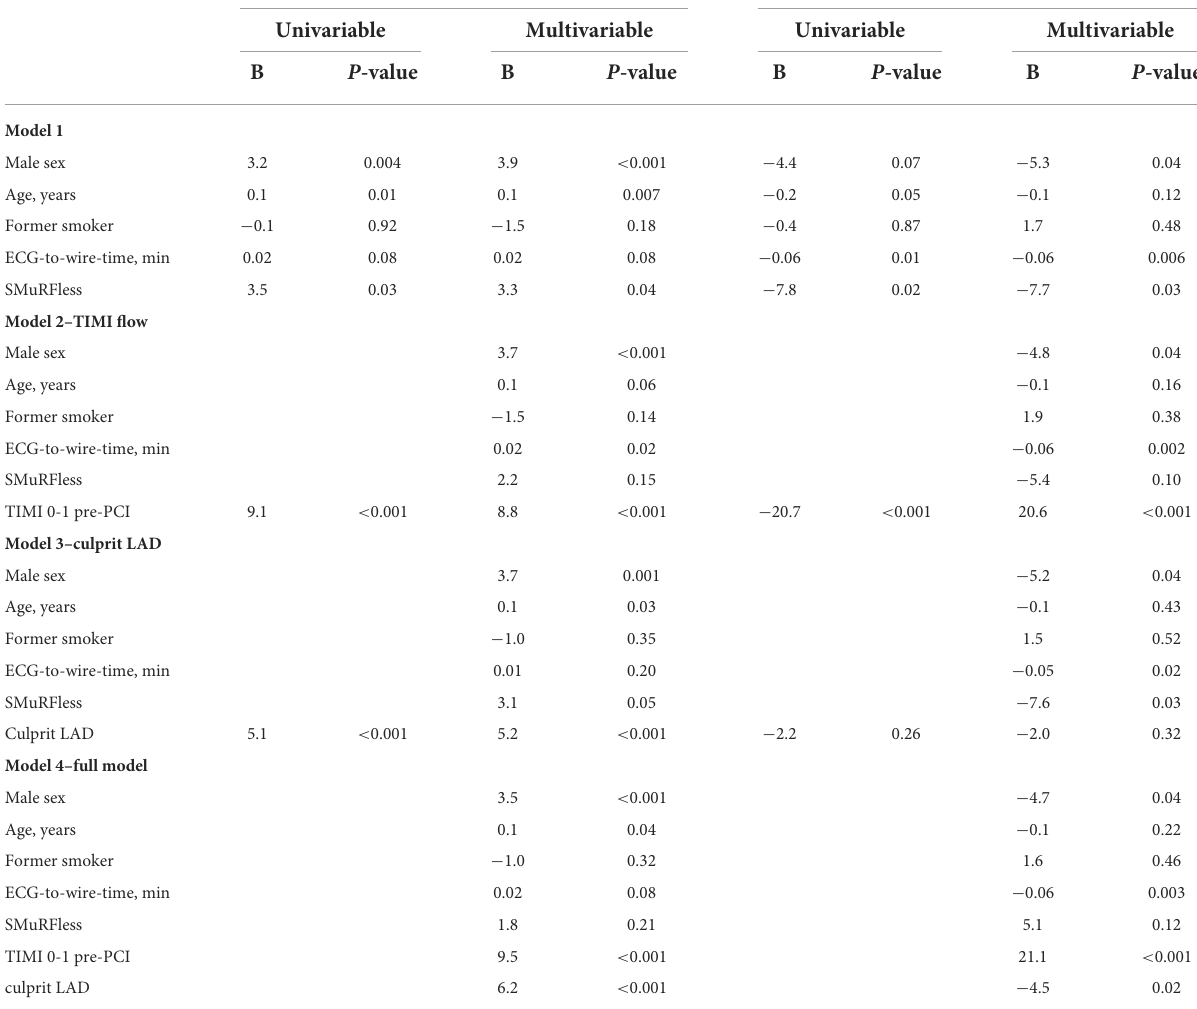
TABLE 4 Multivariable linear regression analysis for predictors of acute infarct size and MSI. Acute infarct size